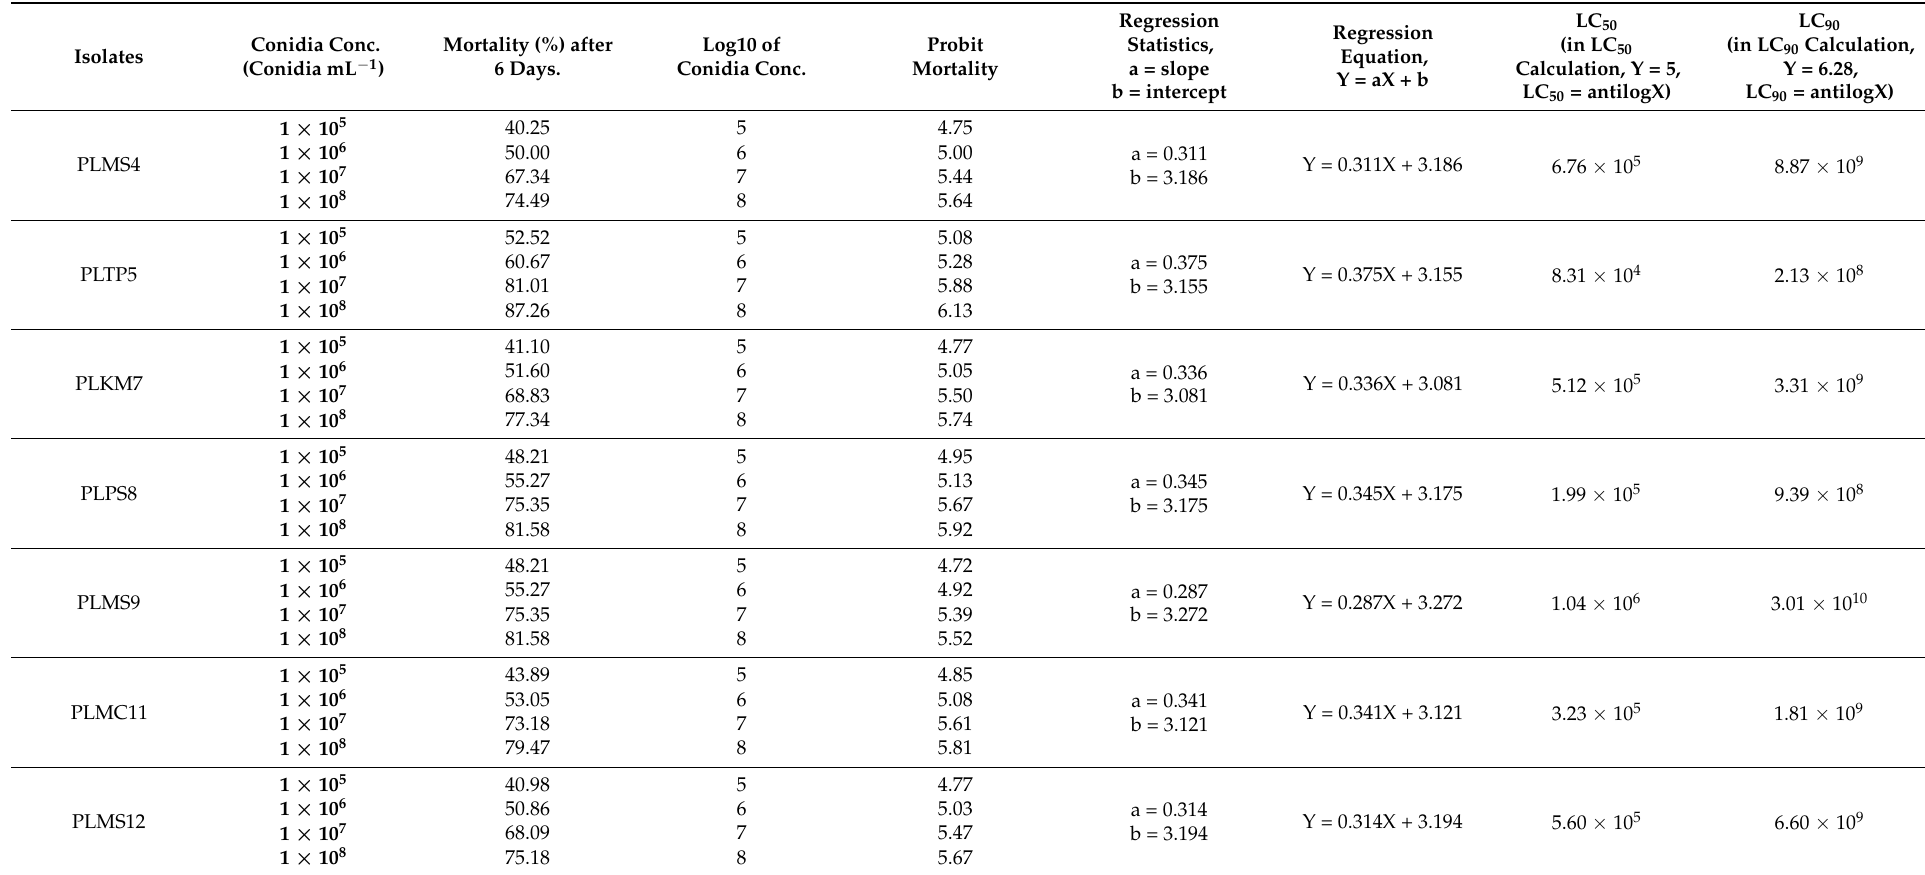
Table 4. LC 50 and LC 90 values for the efficacy of the isolates against SWA adults, using different concentrations (1 × 10 5 to 1 × 10 8 conidia mL − 1 ) of conidia suspension, after 6 days’